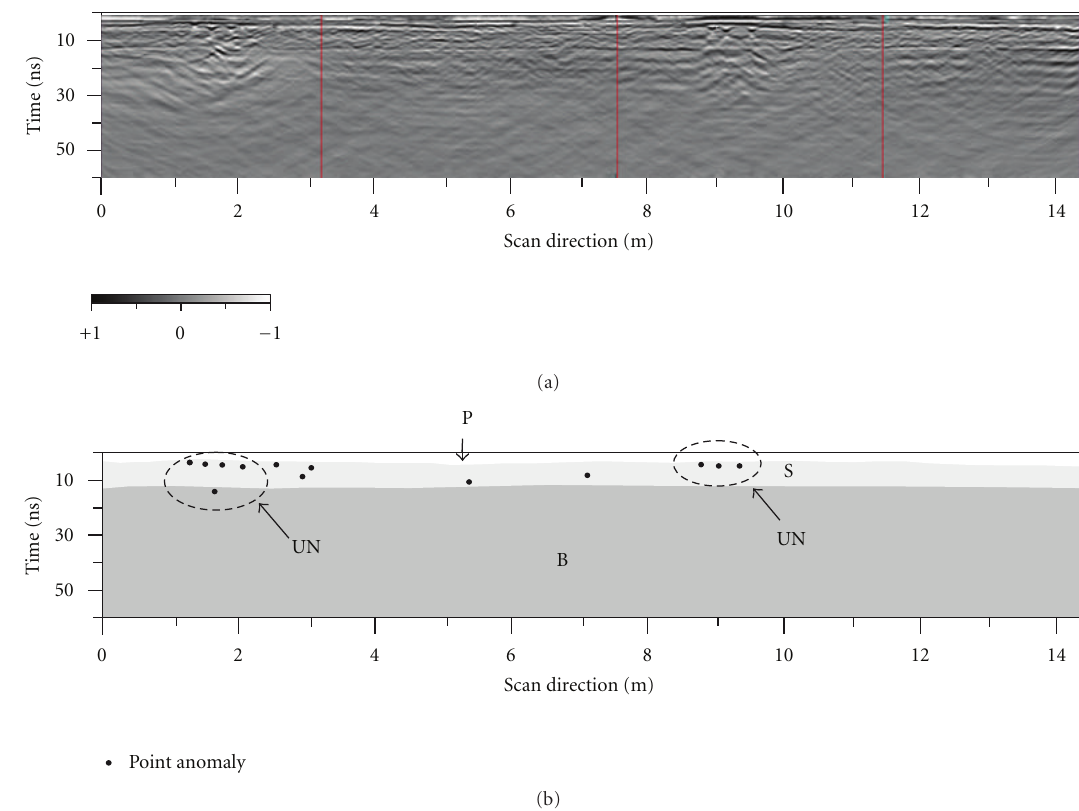
Figure 4: 600 MHz migrated radar longitudinal section (a) and its line drawing (b) of the undamaged road section reported in Figure 3; di ff erent road layers (P: pavement; S: subgrade; B: bedrock) and buried underground network (UN) are